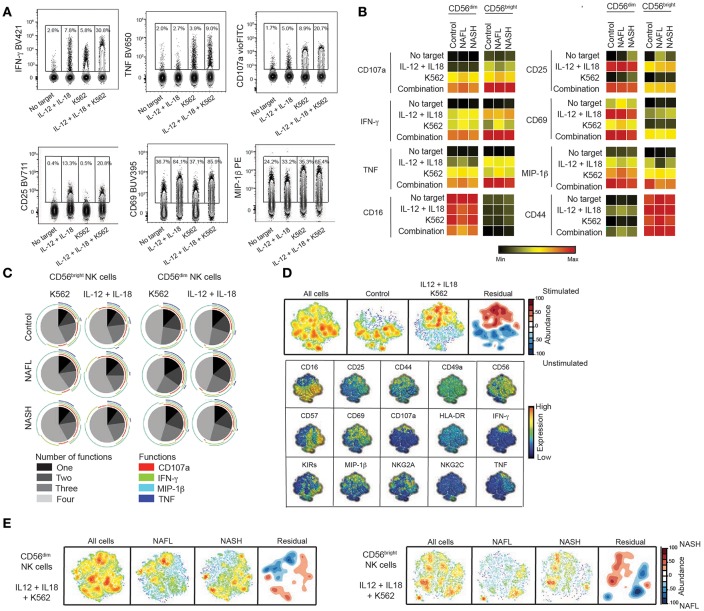
Retained functional capacity of circulating NK cells in NAFLD. (A) Representative concatenated flow cytometry plots showing CD56dim NK cell responses following the indicated stimulations. (B) Heat map summarizing the mean frequency of responding NK cells for the measured functions and indicated stimulations in healthy controls (n = 15), NAFL patients (n = 10), and NASH patients (n = 16). (C) Multifunctional analysis of the combination of degranulation (CD107a) and cytokine production (IFN-γ, MIP-1β, and TNF) responses for IL-12 + IL-18 stimulation and/or co-culture with K562 target cells. (D) SNE plots of total cells from healthy donors subsequently divided in stimulated and un-stimulated cells. The residual plot highlights the decreased (blue) or more highly expressed (red) areas in the stimulated cells. Underneath, individual plots of the expression of 15 single markers are shown. (E) SNE plots depicting the difference between CD56dim (left) and CD56bright (right) NK cells from NAFL and NASH patients after IL-12 + IL-18 + K562 stimulation where the density plots highlight the specific changes in NASH patients.